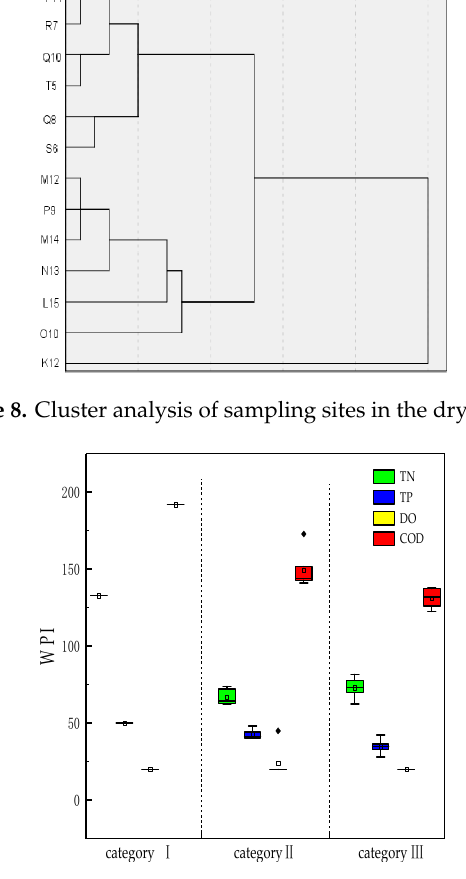
Figure 9. Box and whisker plots of spatial variation in the dry season.